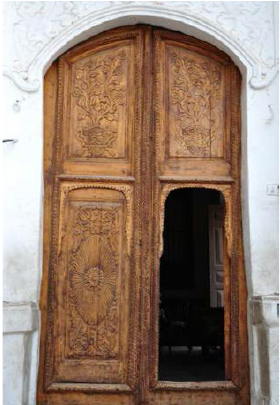
Figure 4. An examples of the wooden doors in Jeddah (Source: SCTA, 2013)